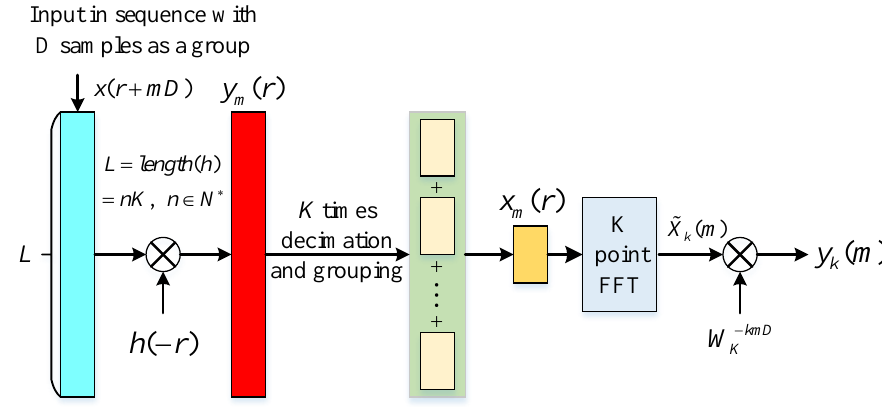
Figure 5. The weighted overlap-add (WOLA) channelization